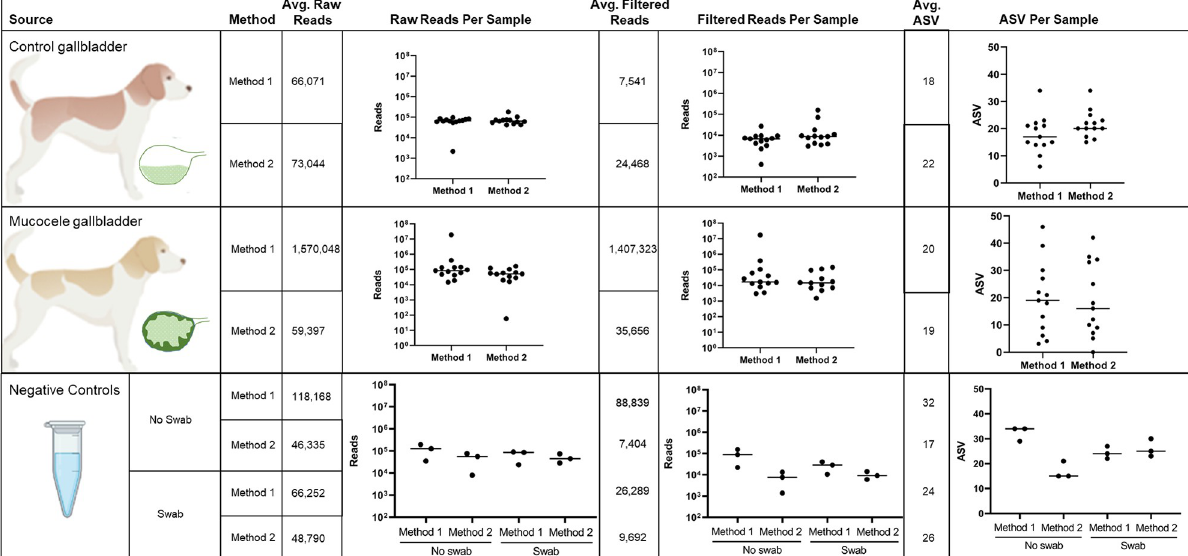
PLOS ONE | https://doi.org/10.1371/journal.pone.0281432 February 10,